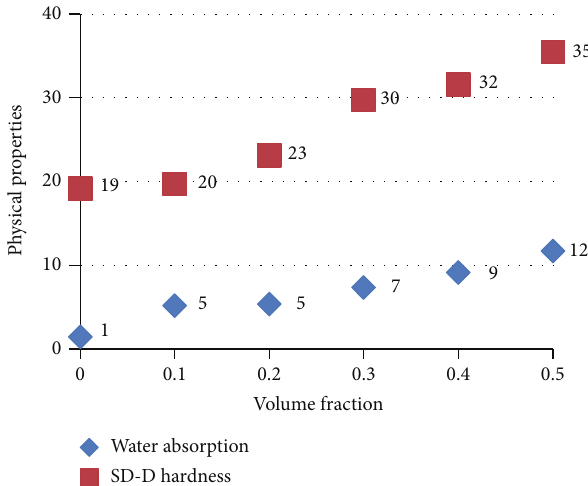
Figure 6: Mechanical properties of hybrid GFRP fibre